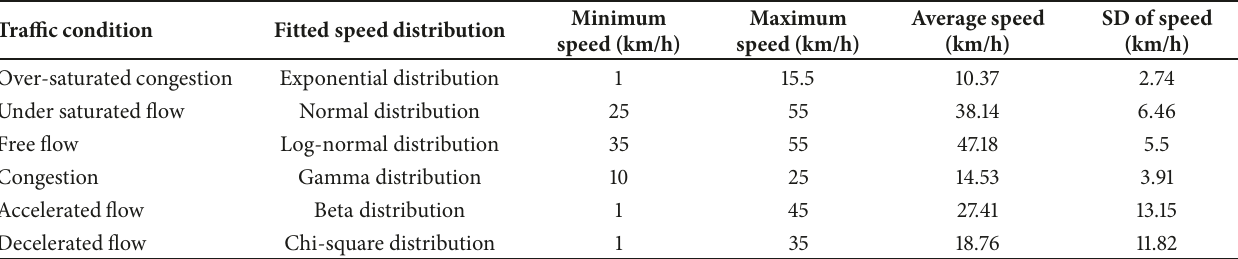
Table 1: Specifications of traffic speed in different traffic